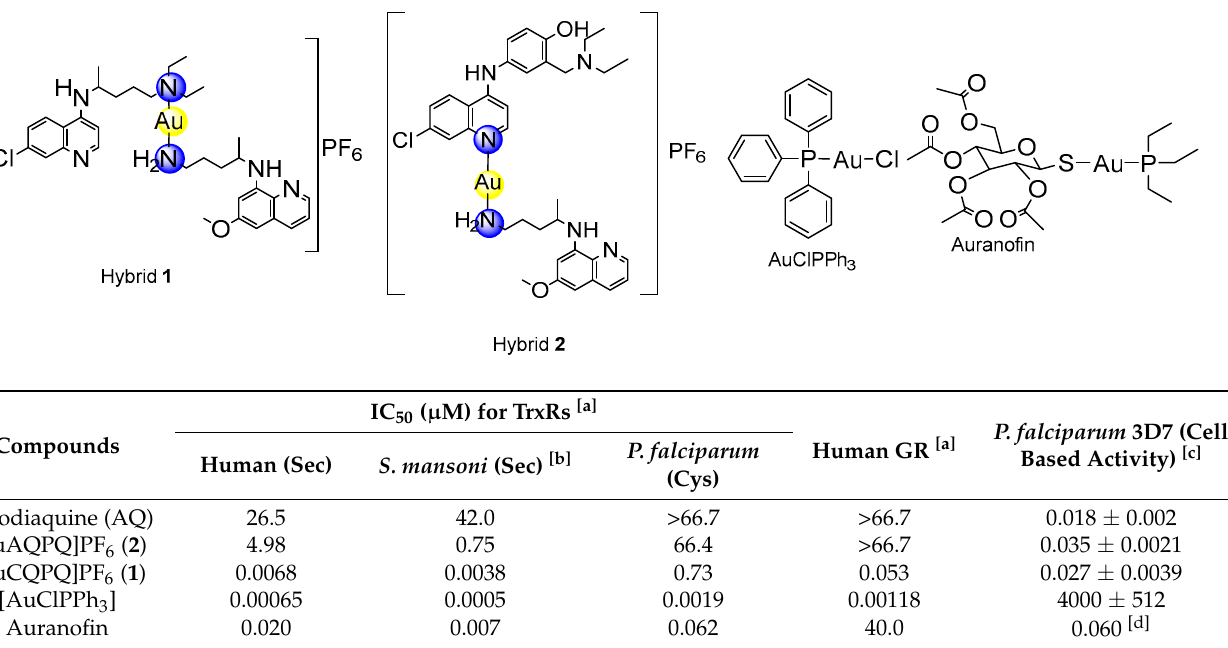
Table 3. Effects of compounds on the thiol redox homeostasis as inferred by the inhibitory effects on the enzymatic activity of recombinant flavoproteins.